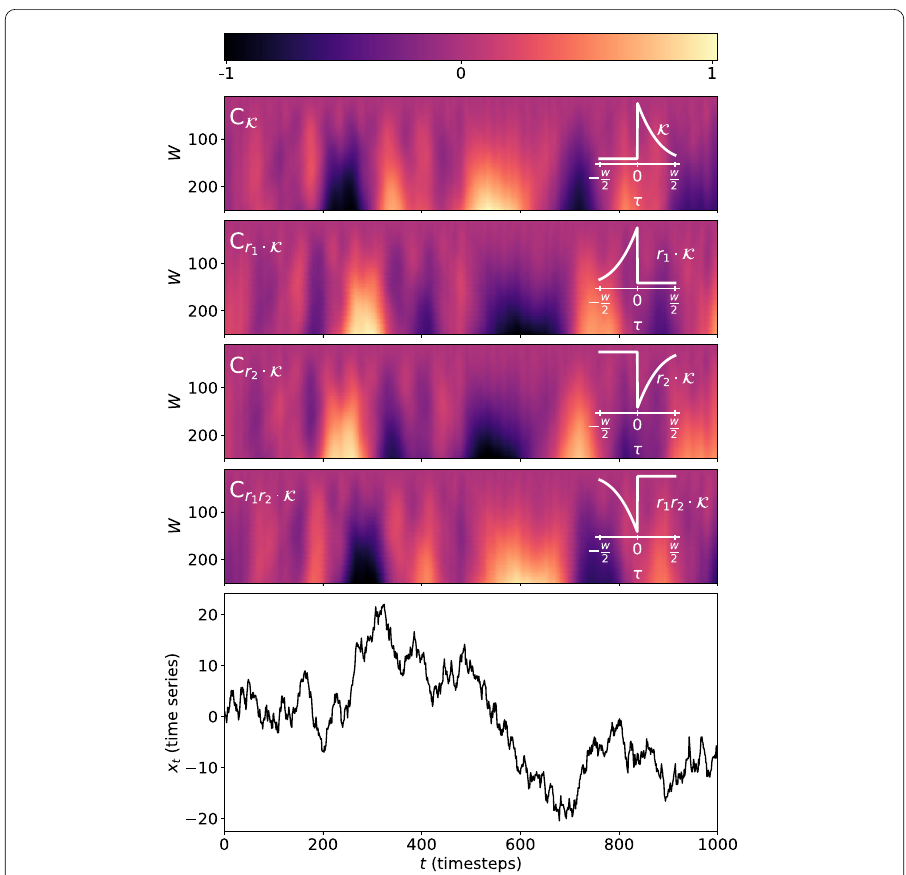
Figure 4 Effects of the reflection group R 4 on the shocklet transform. The top four panels display the results of the shocklet transform of a random walk x t = x t –1 + z t with z t ∼ N (0,1), displayed in the bottom